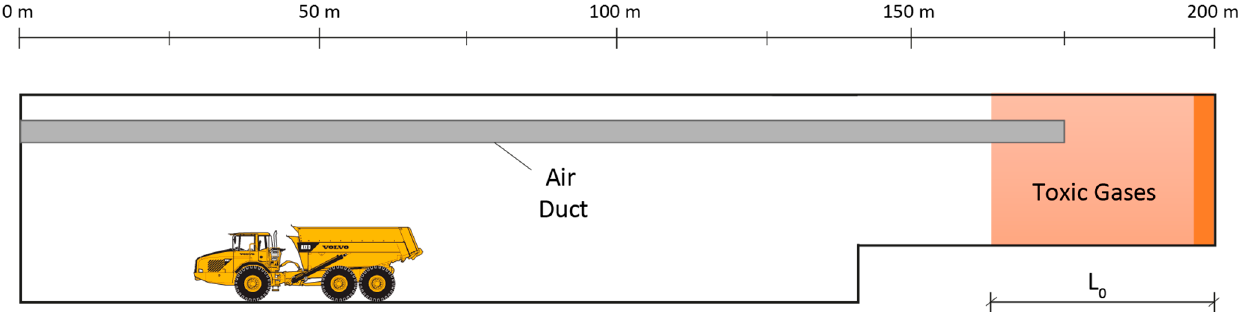
Figure 1. Longitudinal profile of the tunnel, with the ventilation duct and the toxic gases located in the tunnel face after blasting.